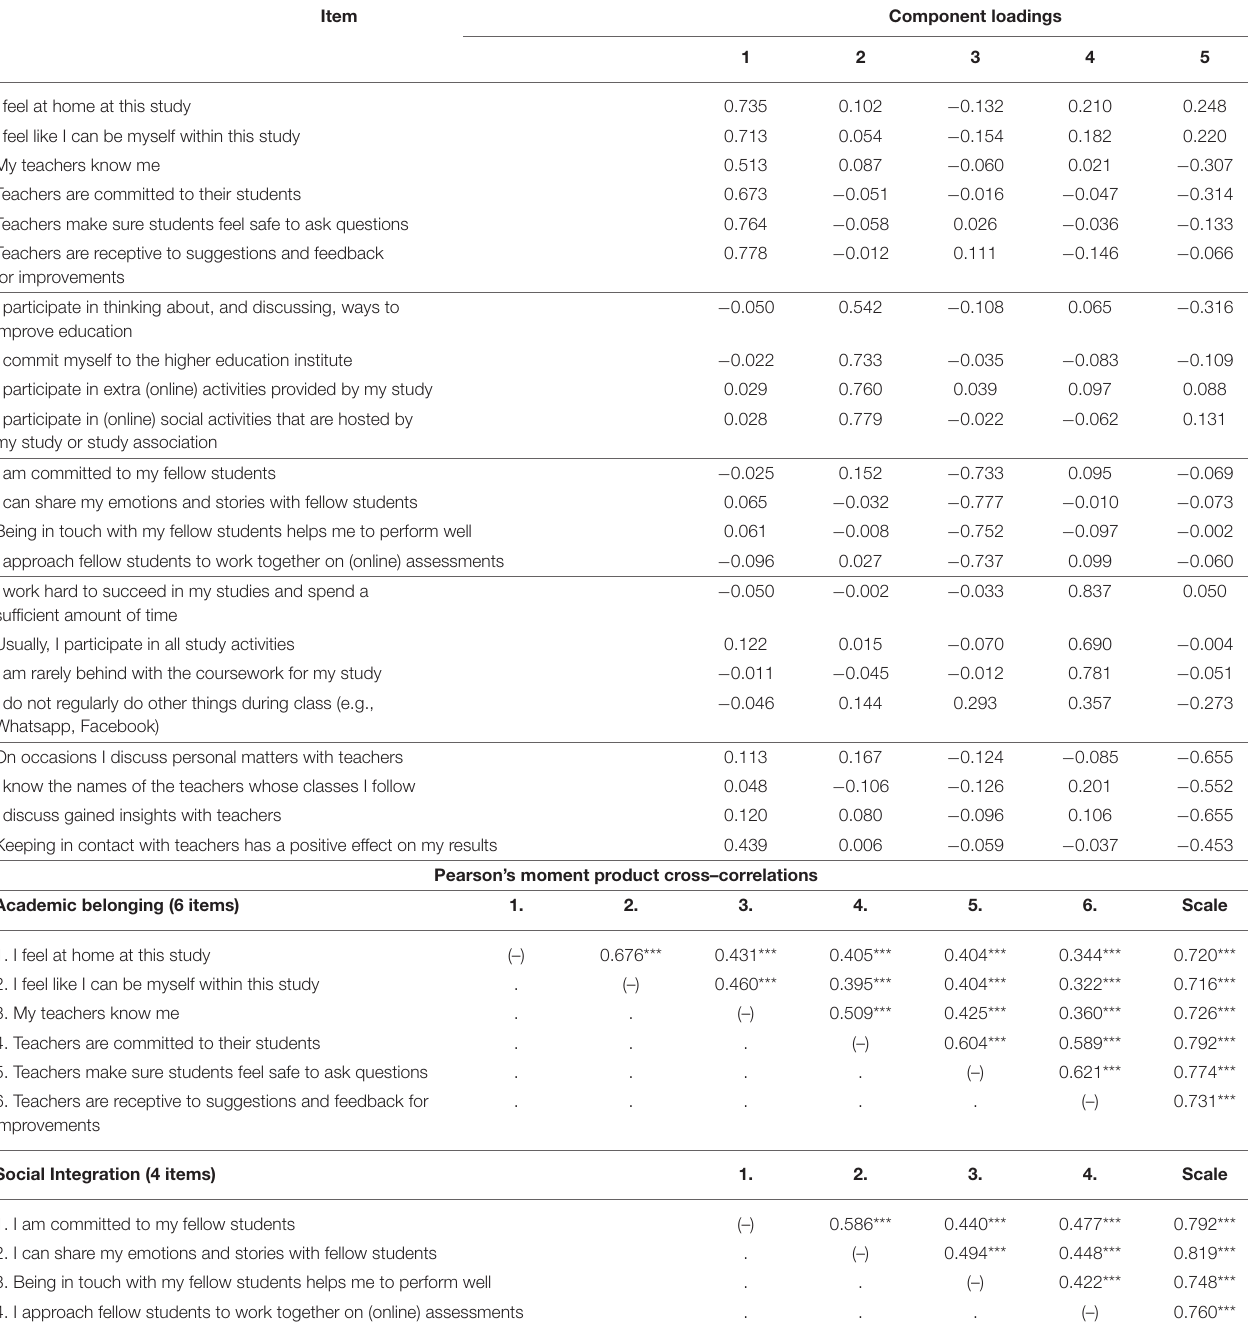
TABLE 1 | Scale assessment using Oblimin principal components analysis with Kaizer Normalization and Pearson’s moment product correlation coefficient analysis for items and scale constructs of academic belonging.